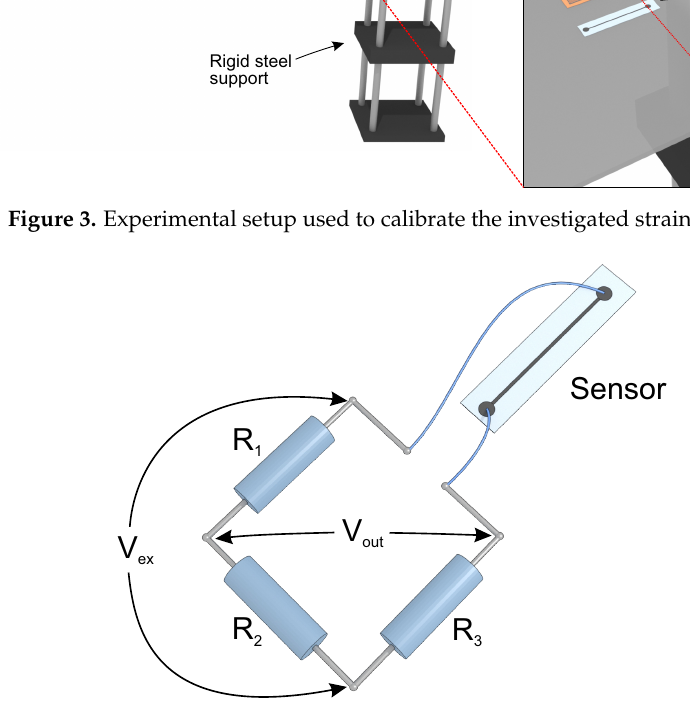
Figure 4. Schematic of a strain sensor connected to the quarter Wheatstone bridge